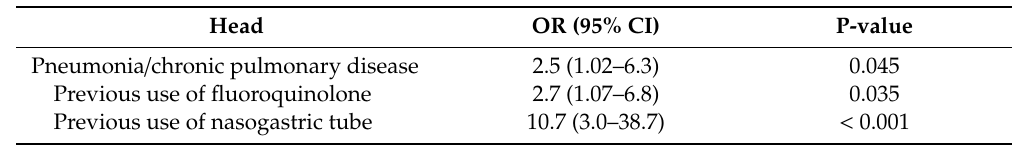
Table 3. Risk factors for infection and / or colonization of carbapenemase-producing Enterobacterales in medical intensive care unit using multivariate